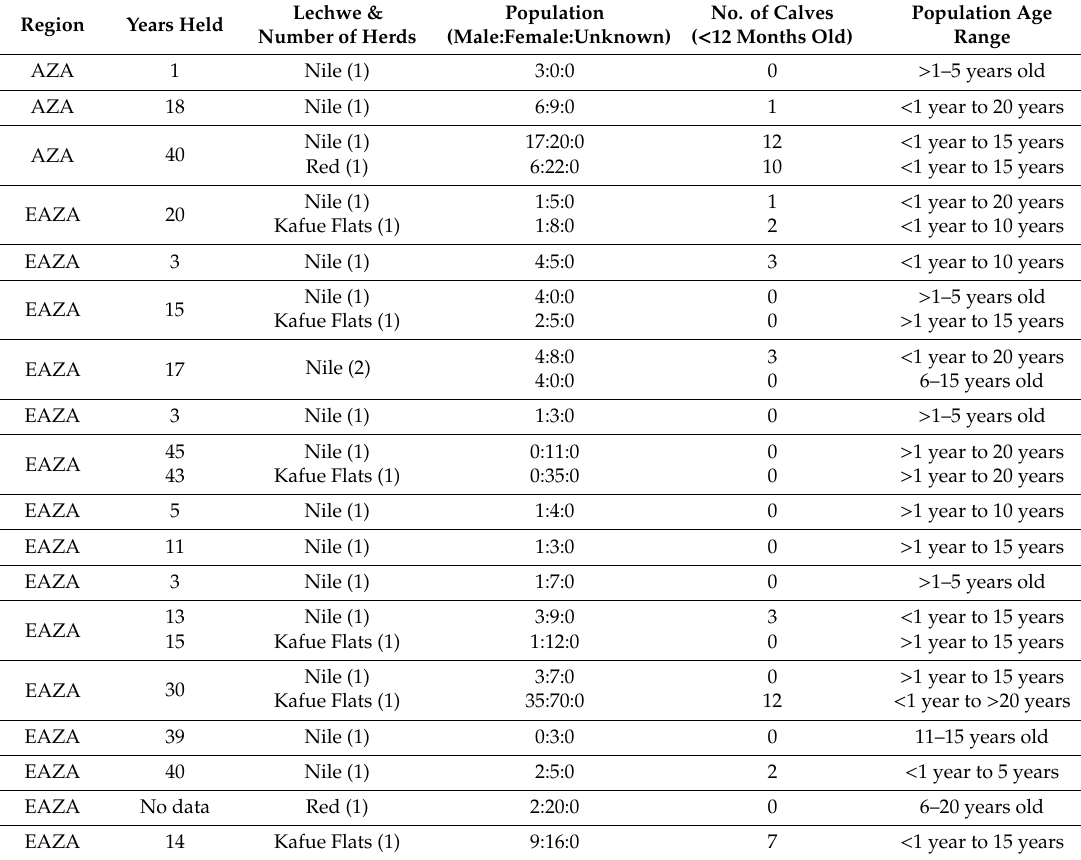
Table 2. Population details for the zoos that were sampled (correct as of 31 December 2018).